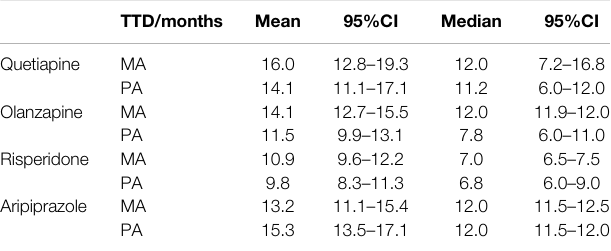
TABLE 6 | Comparison of TTD among four atypical